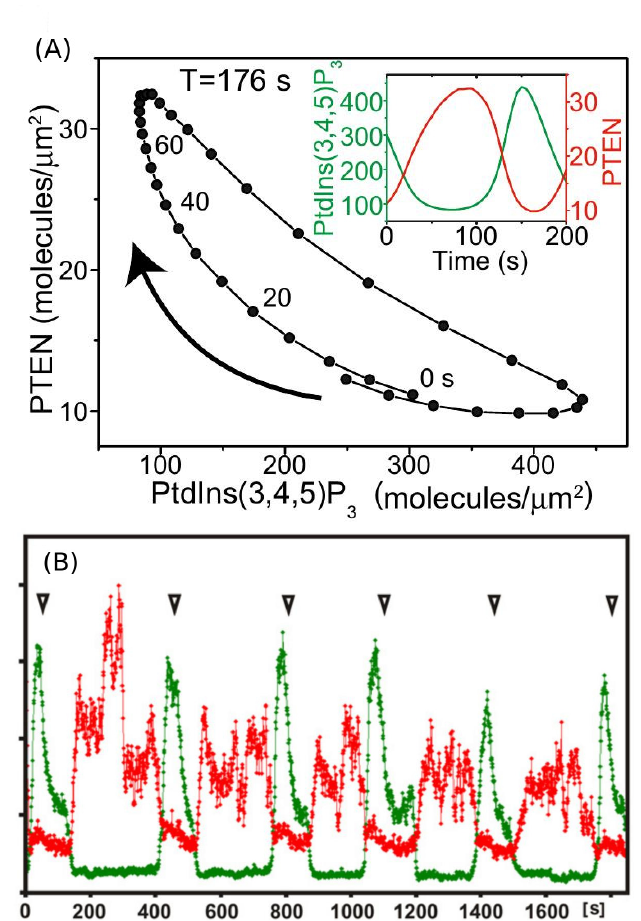
Figure 10. ( A ) The predicted PIP3-PTEN phase plane. From Arai et al. [73]. ( B ) A plot of PTEN (red) and PIP3 (green) vs. time taken in a small spot on the membrane. From Gerisch et al.